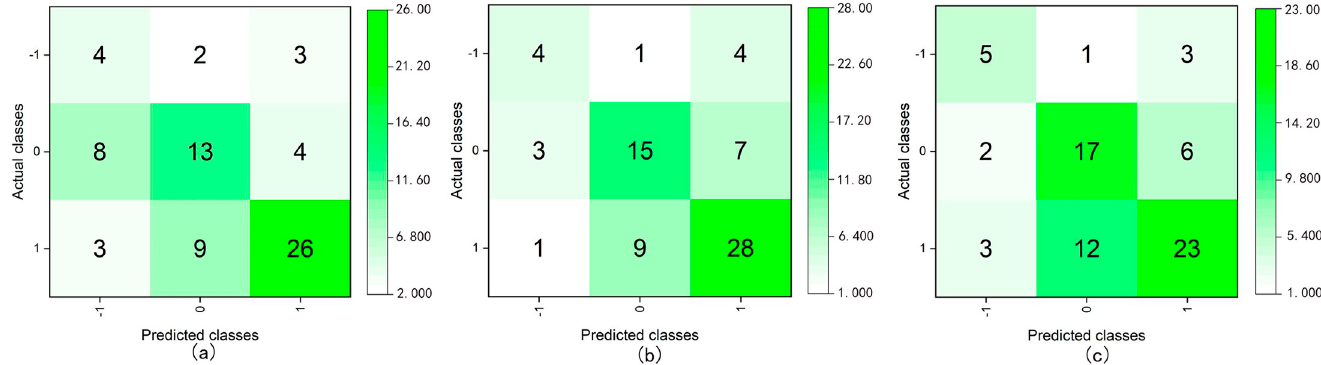
Fig 10. Confusion matrices of the ternary class classification for external validation using DT C5.0 (boosting) (a), RF (bagging) (b), and neural network (boosting) (c).